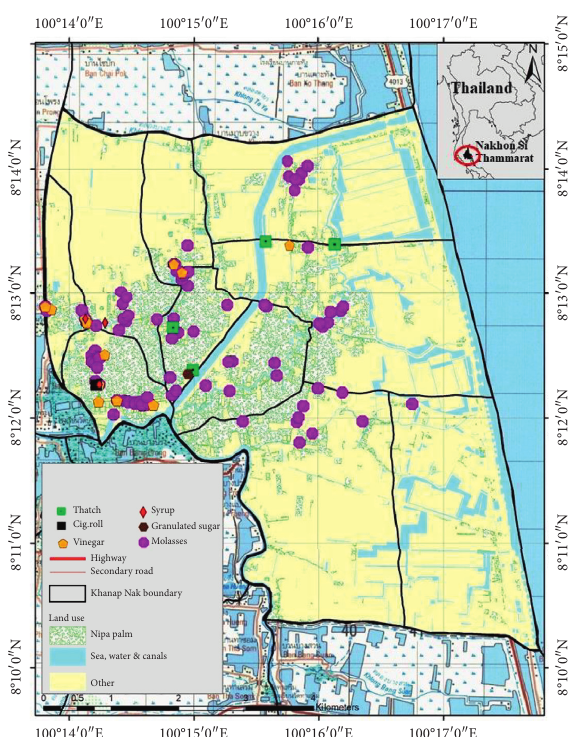
Figure 6: Dispersion of products from nipa palm forest resources in Khanap Nak, Pak